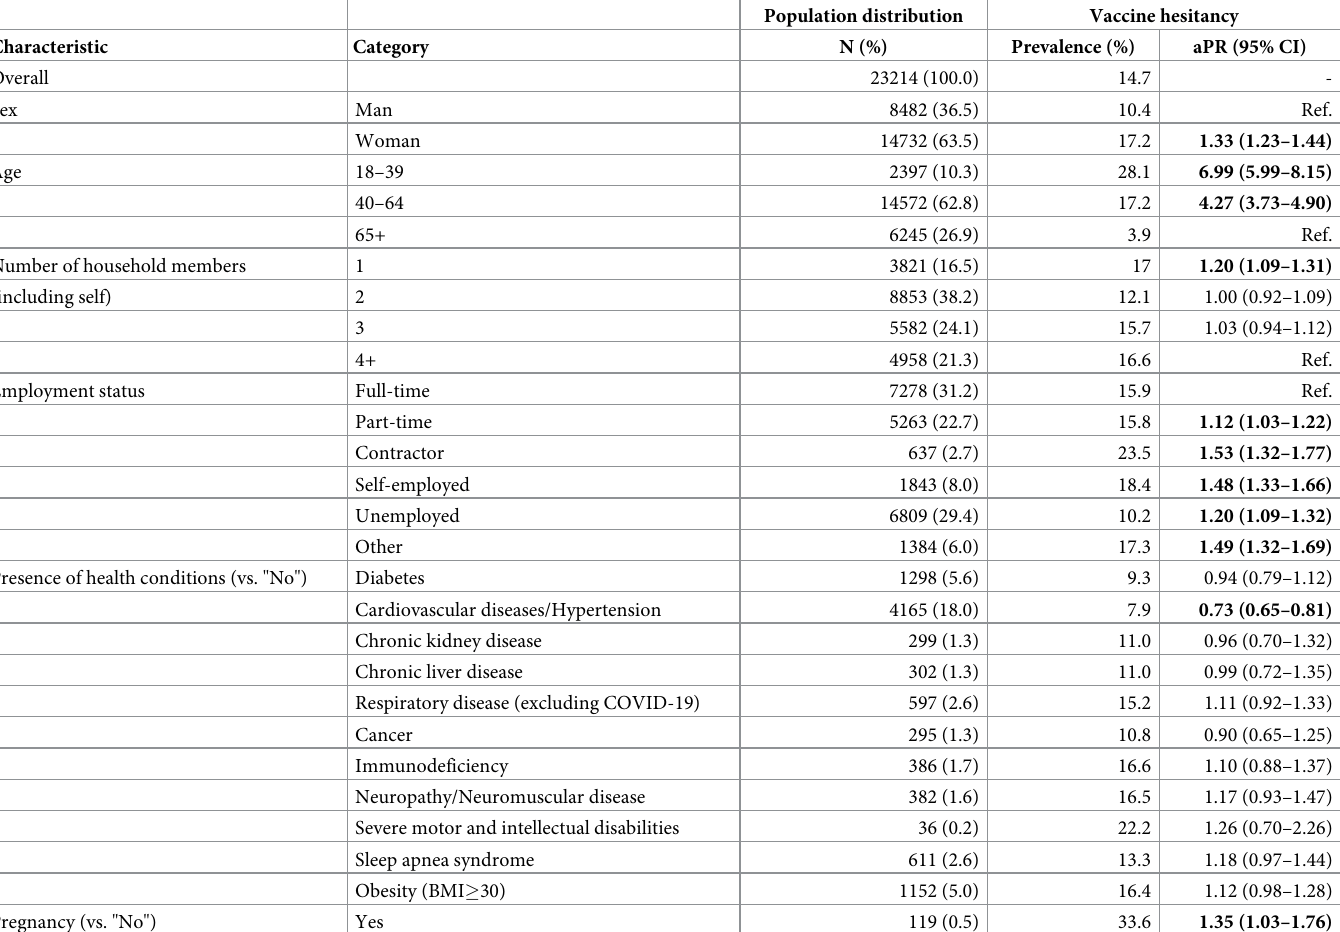
Table 1. Prevalence and associated factors of COVID-19 vaccine hesitancy, Osaka, Japan, June